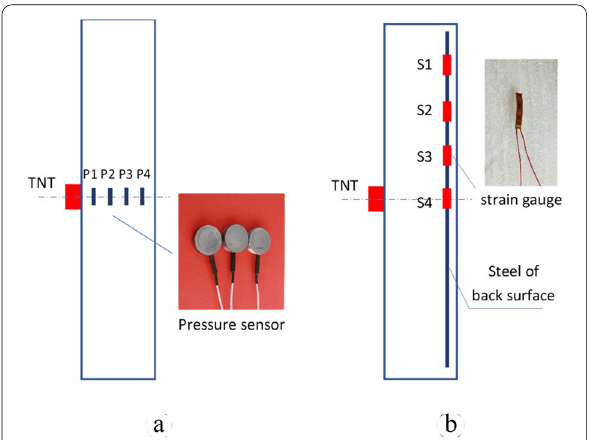
Fig. 8 Layout of a pressure sensor and b strain